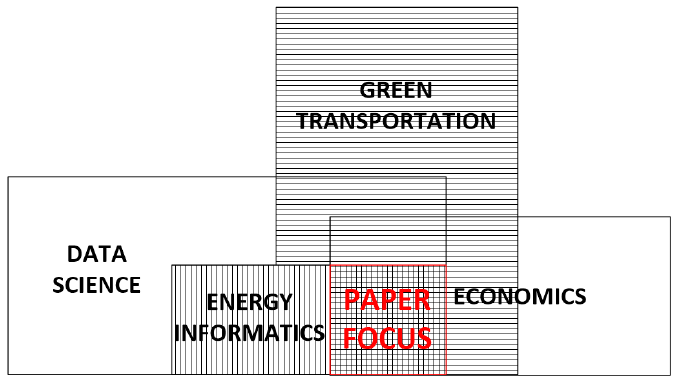
Figure 1. Thematic positioning of the paper: intersection of interdisciplinary fields.